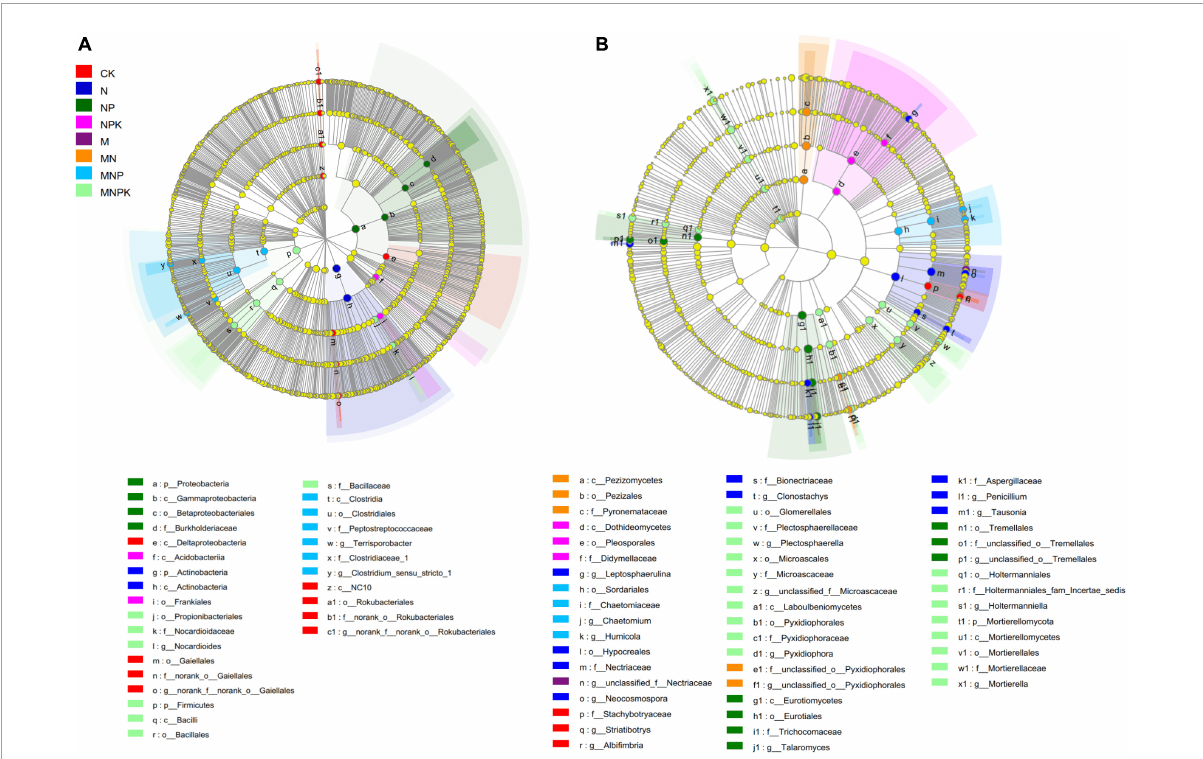
FIGURE3 The linear discriminant analysis effect size (LEfSe) showed the significantly different taxa of bacterial communities (A) and fungal communities (B) under different treatments. The threshold of LDA score was 4.0.